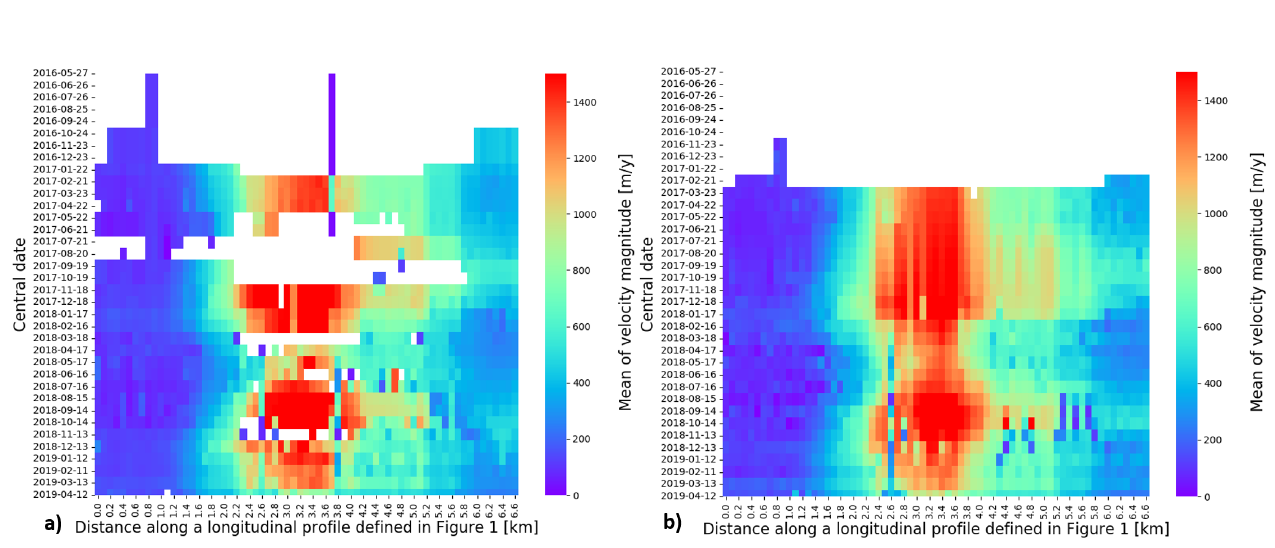
Figure 9. Color-encoded matrix of velocity magnitude according to the central date of the velocity and the distance along a longitudinal profile represented in red in Figure 1. This longitudinal profile goes from the terminus of the Fox glacier to the accumulation part, from the North-Est to the South-West. The color-encoded matrix stands for a) the 30-days moving average of velocity observations b) Regular Leap Frog velocity time series with a temporal sampling of 30